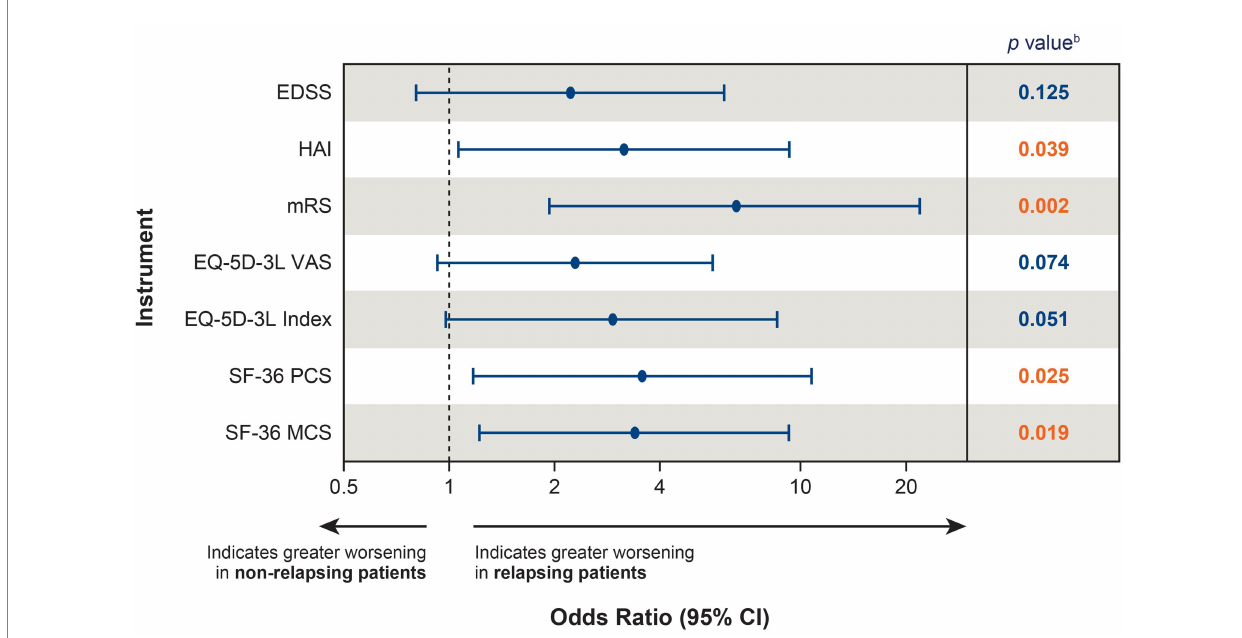
FIGURE 4 Likelihood of clinically meaningful worsening a between relapsing ( n = 27) and non-relapsing ( n = 116) patients. a Clinically meaningful worsening was calculated between the PREVENT baseline score and the score at the end of the OLE; for patients who did not roll over to the OLE, the score at the end of the PREVENT study was used. b Red font indicates p < 0.05. CI, confidence interval; EDSS, Expanded Disability Status Scale; EQ-5D-3L, European Quality of Life 5-Dimension questionnaire 3-level; HAI, Hauser Ambulation Index; MCS, mental component summary; mRS, modified Rankin scale; OLE, open-label extension; PCS, physical component summary; PREVENT, Prevention of Relapses in Neuromyelitis Optica; SF-36, 36-Item Short-Form Health Survey; VAS, visual analogue scale.